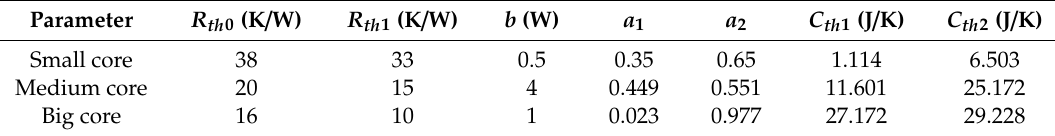
Table 4. Values of parameters describing Z thC ( t ) of inductors with cup cores.